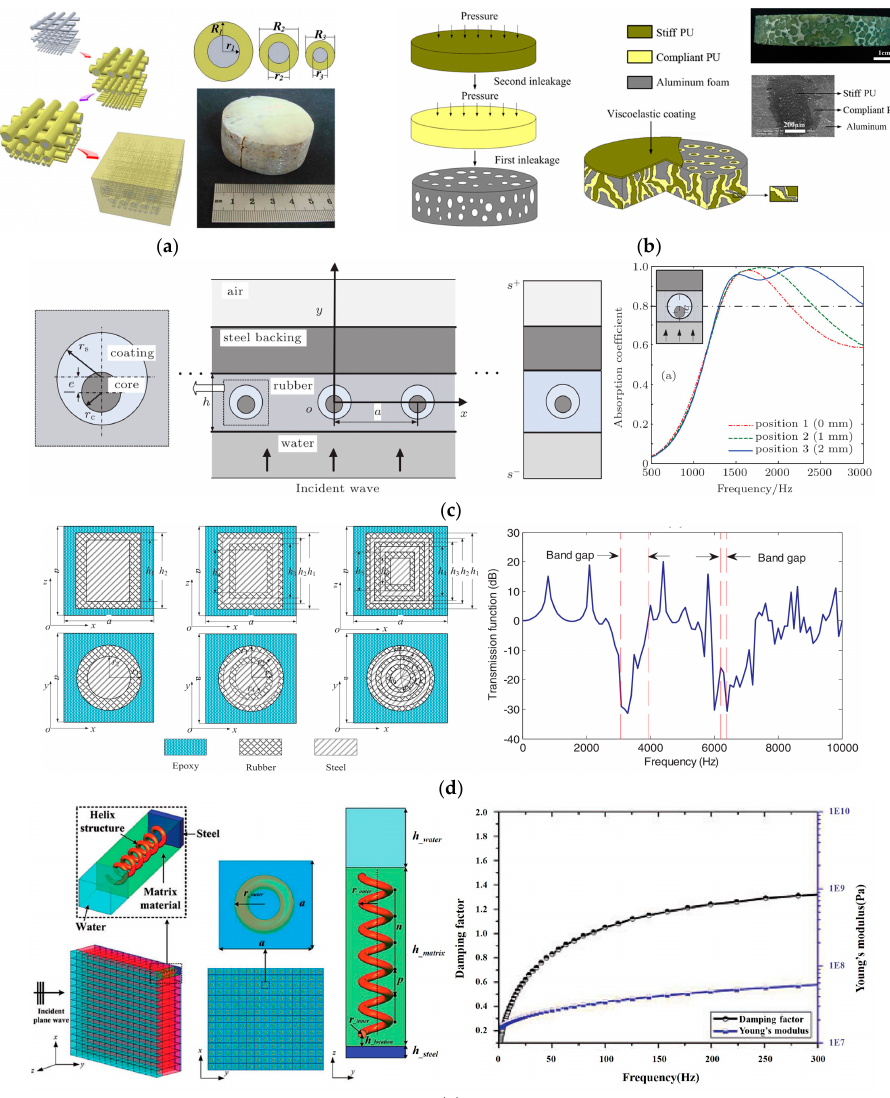
Figure 6. Acoustic properties of acoustic coatings with rigid inclusions or scatterers. ( a ) Schematic of synthesis route and optical image of locally resonant phononic woodpile [31]. ( b ) Schematic of synthesis, the structure of phononic glass, optical and SEM images of a typical phononic glass sample [32]. ( c ) Cross-section of one locally resonant scatterer unit, absorption structure with steel backing, one Bloch unit cell, and comparison among the absorptances for three core positions [35]. ( d ) Conventional local resonance acoustic metamaterials (LRAMs), double-layered cylindrical scatterers, three-layered cylindrical scatterers, and band diagram of the LRAMs with three-layered locally resonant scatterers [36]. ( e ) Three-dimensional geometric dimensions and experimental results of dynamic mechanical parameters of viscoelastic damping rubber